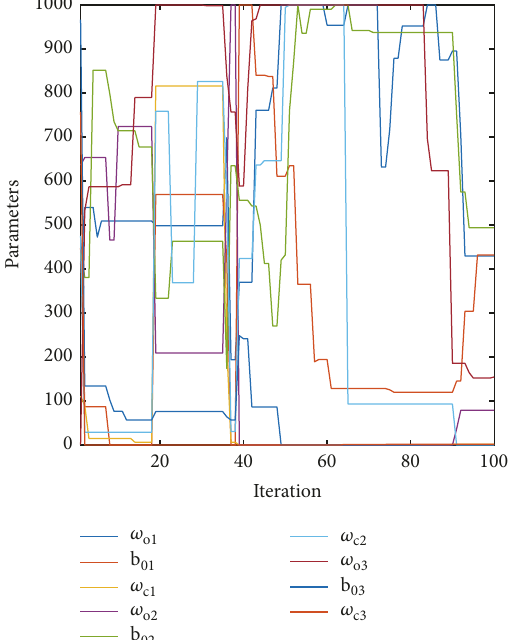
Figure 4: Evolving curves of the control parameters.